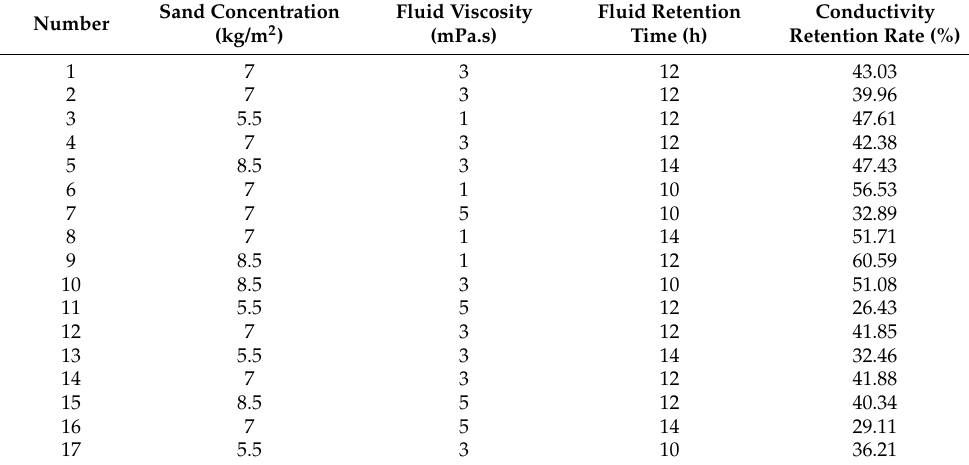
Table 3. Results of the response surface test.